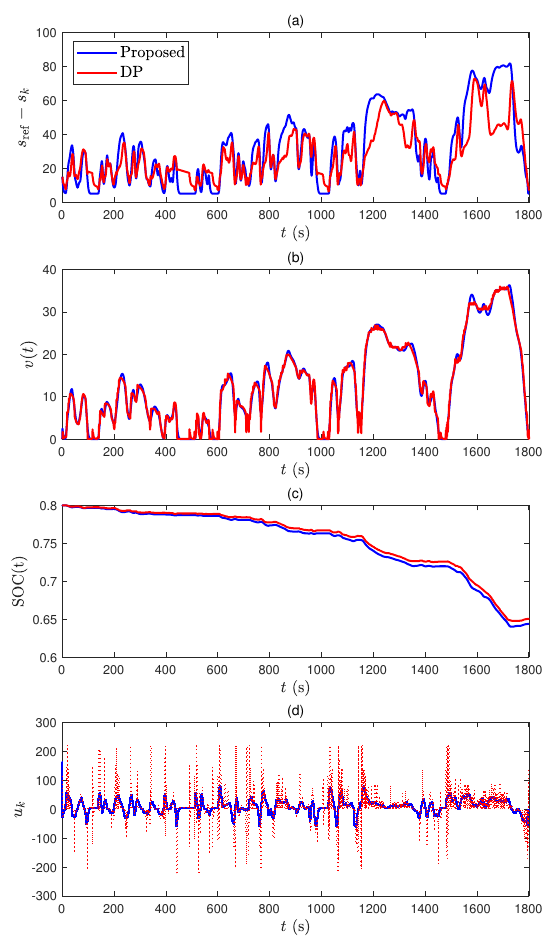
Figure 10. Comparison between model prediction control (MPC) and DP for the WLTC driving cycle, ( a ) distance difference between ego car and leader car, ( b ) speed profiles, ( c ) battery SOC trajectories, and ( d ) control